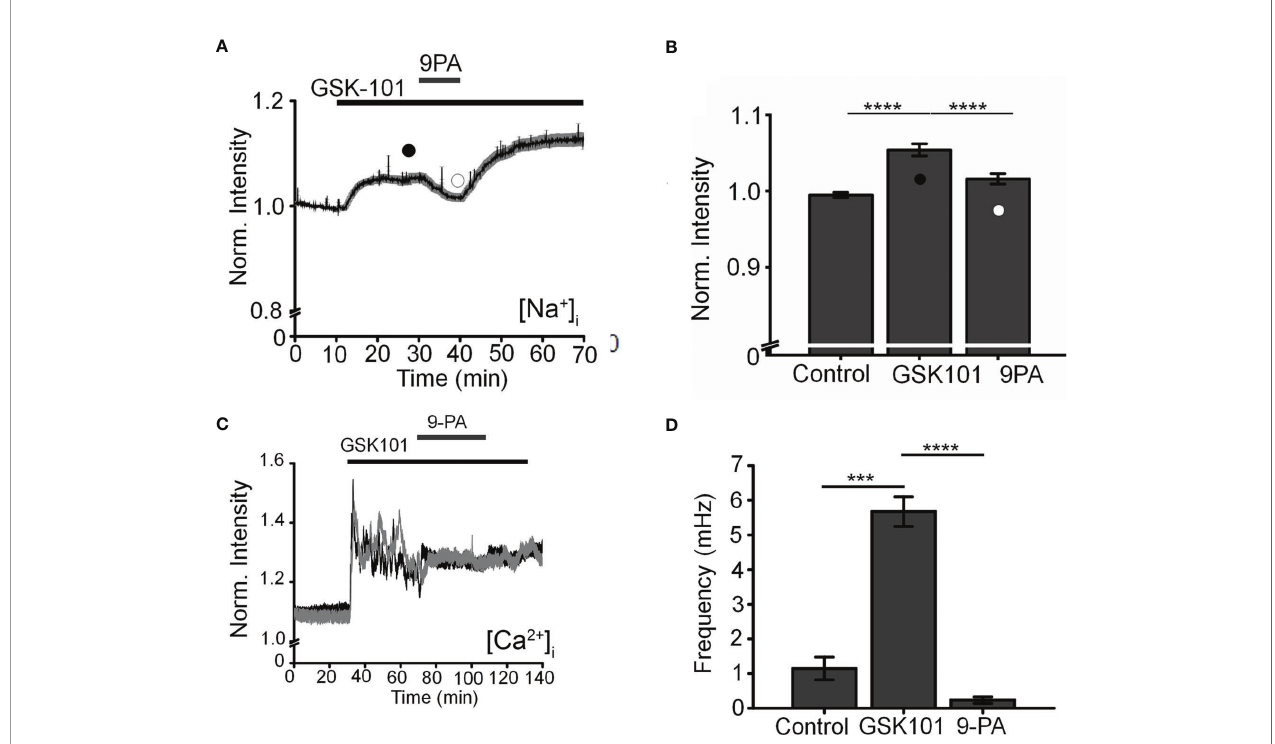
FIGURE 4 | TRPM4 mediates TRPV4-induced Na + in fl ux and facilitates Ca 2+ fl uctuations. (A). Averaged time lapse ratio in NaTRIUM Green-loaded TM cells. GSK101-evoked increase in [Na + ] i is partially and reversibly suppressed by 9-PA. (B) Mean ± S.E.M. values for the experiment in A (n = 10). Black and white symbols represent time at which the intensity was measured. (C) GSK101-evoked [Ca 2+ ] i oscillations are suppressed by 9-PA (n = 39). (D) Summary of the data shown in (C) , as mean ± S.E.M. *** = P < 0.001, **** = p < 0.0001, paired-sample